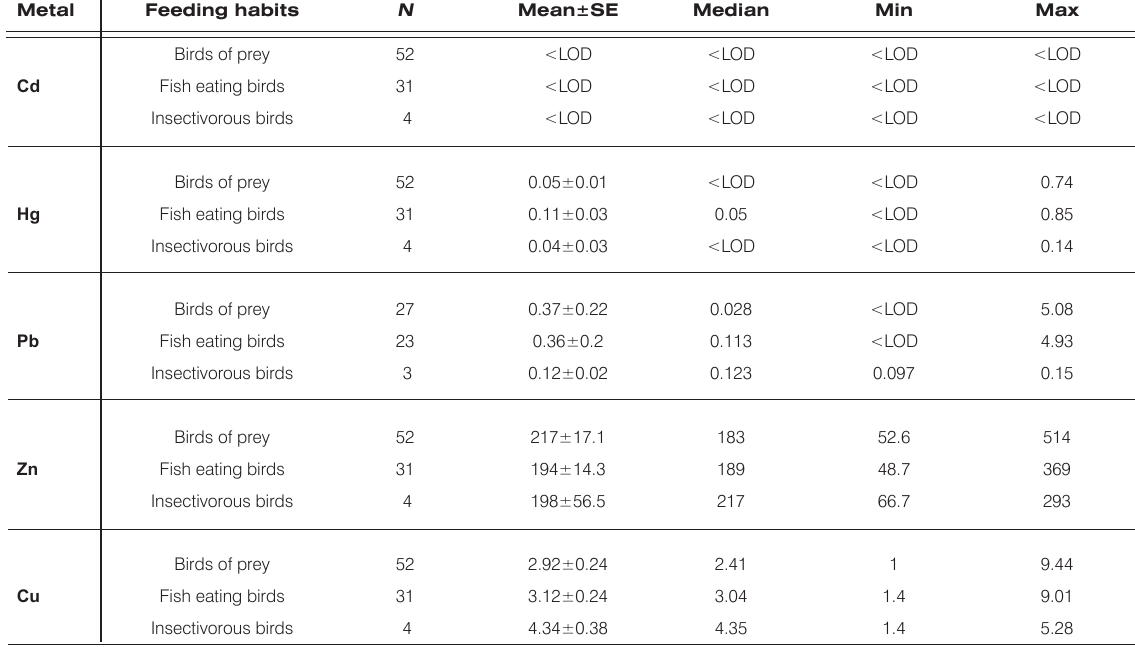
Table 4. Metal concentrations in bone; values are expressed in µg g -1 wet weight Metal